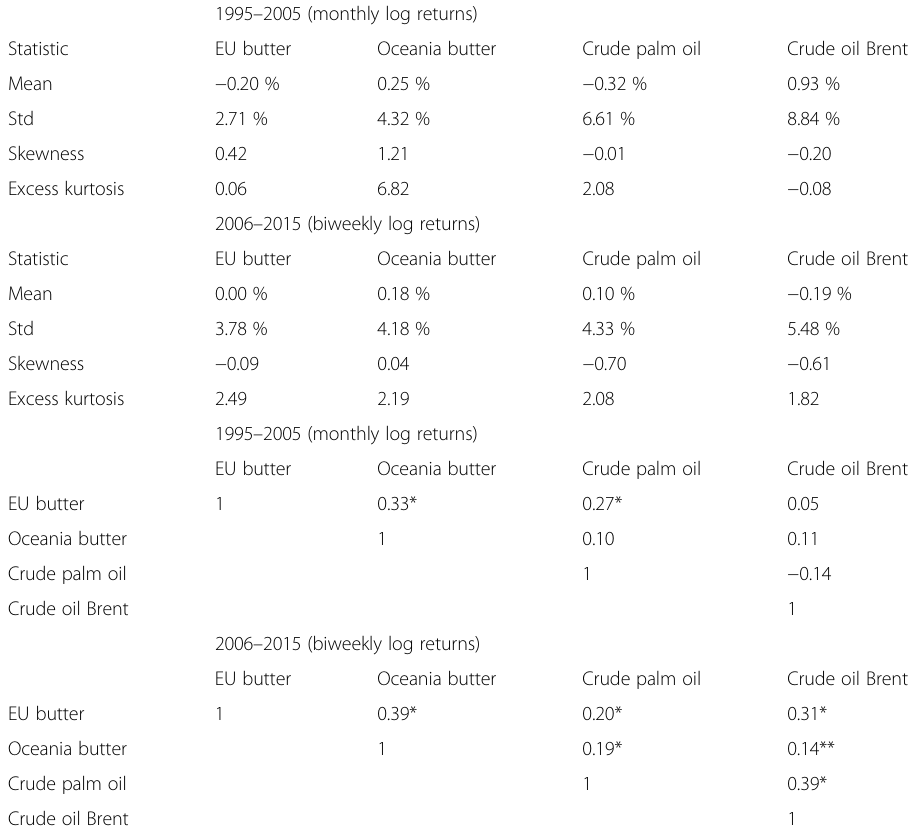
The symbols * and ** denote significance at the 5 and 10 % confidence level,